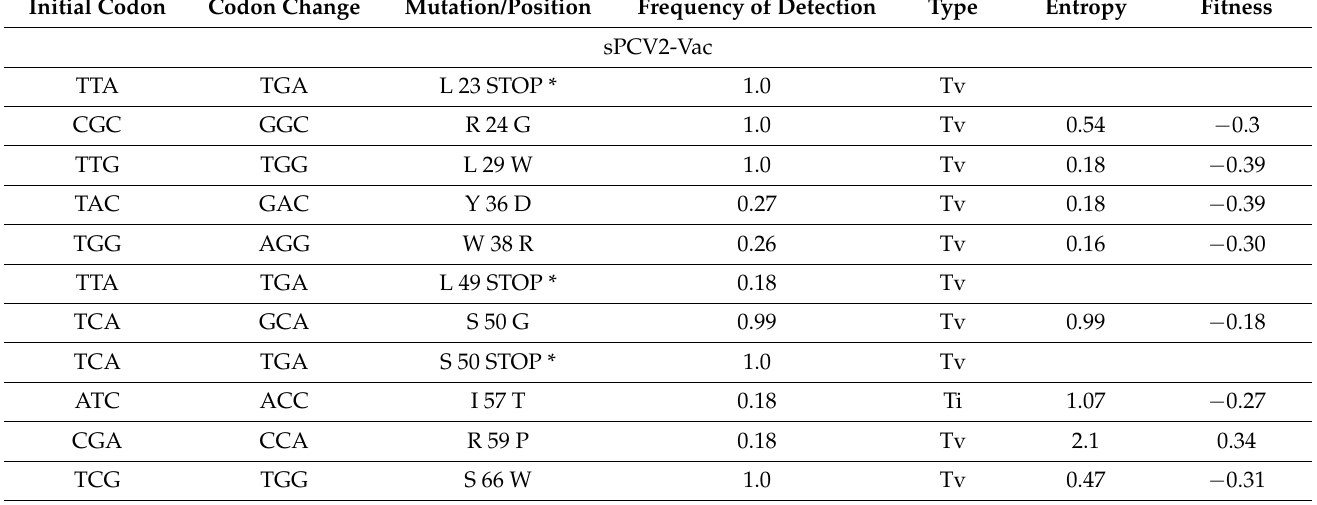
Table 1. Mutations under immune selection